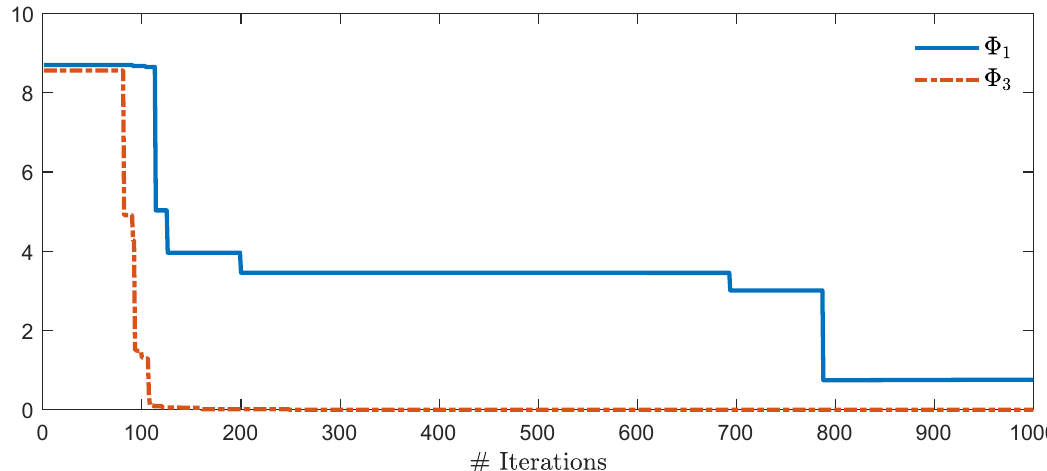
Figure 11. Computed convergence of the solving process in terms of Φ 1 (task performance) and Φ 3 (overshoot), similar to Figure 10.